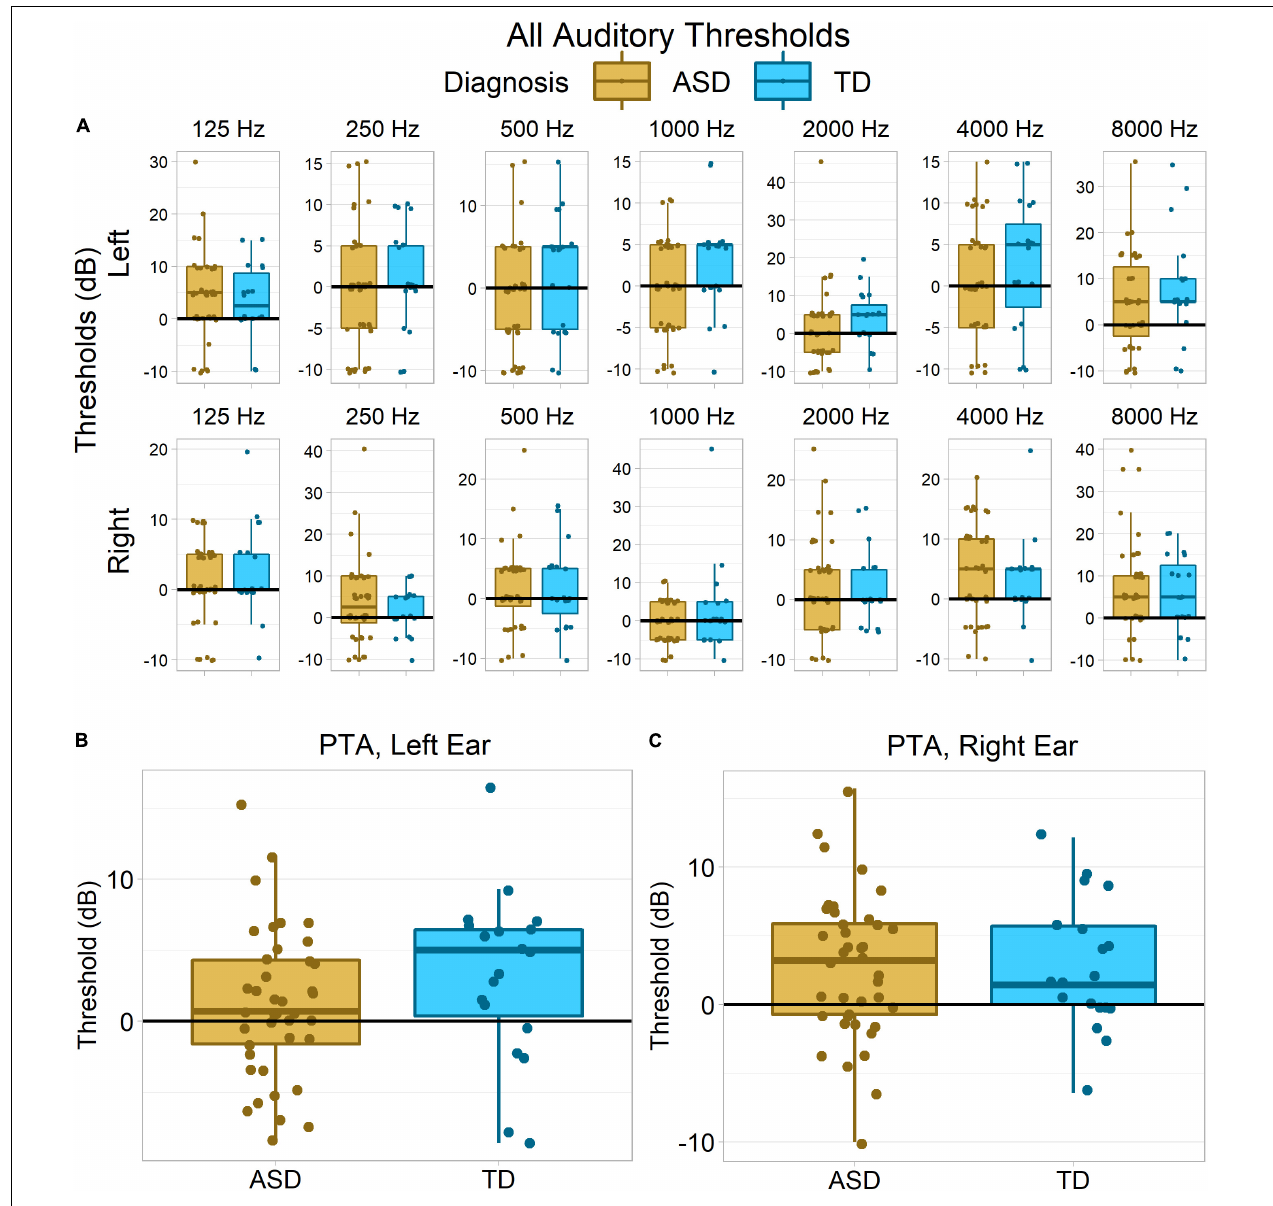
FIGURE 4 | Hearing acuity in each group. No statistically reliable group differences were observed, despite the apparent trend toward greater auditory acuity in the ASD group in the left ear (B) . (A) Hearing thresholds for each tone frequency and ear separately. (B,C) Pure tone average thresholds (collapsing across frequencies) for each